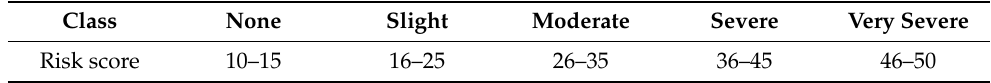
Table 1. Severity classes of salinity